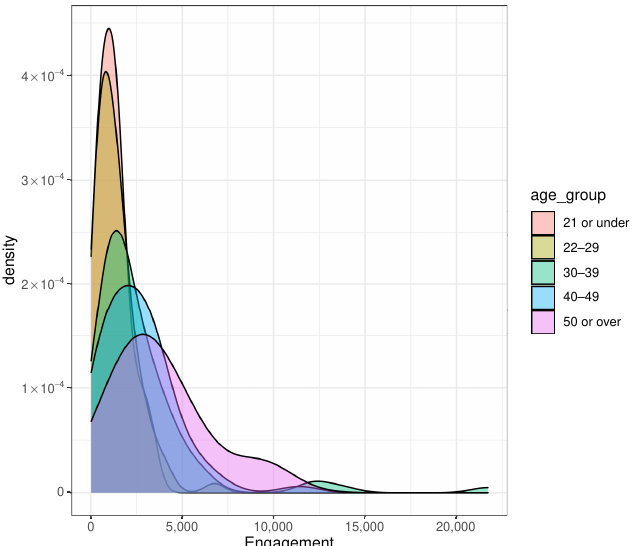
Figure A4. Density plots of the engagement variable of all age groups.